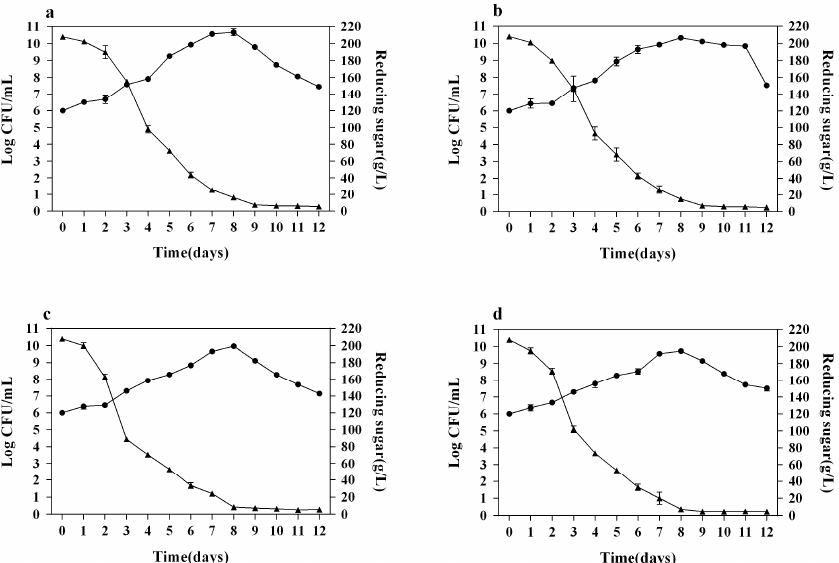
Figure 1. Growth kinetics and sugar consumption kinetics of S. cerevisiae during wine fermentation. ( a ) Wines treated by crude β -glucosidase from I. terricola SLY-4; ( b ) Wines treated by crude β -glucosidase from P. kudriavzevii F2-24; ( c ) Wines treated by crude β -glucosidase from M. pulcherrima HX-13; ( d ) Wines without